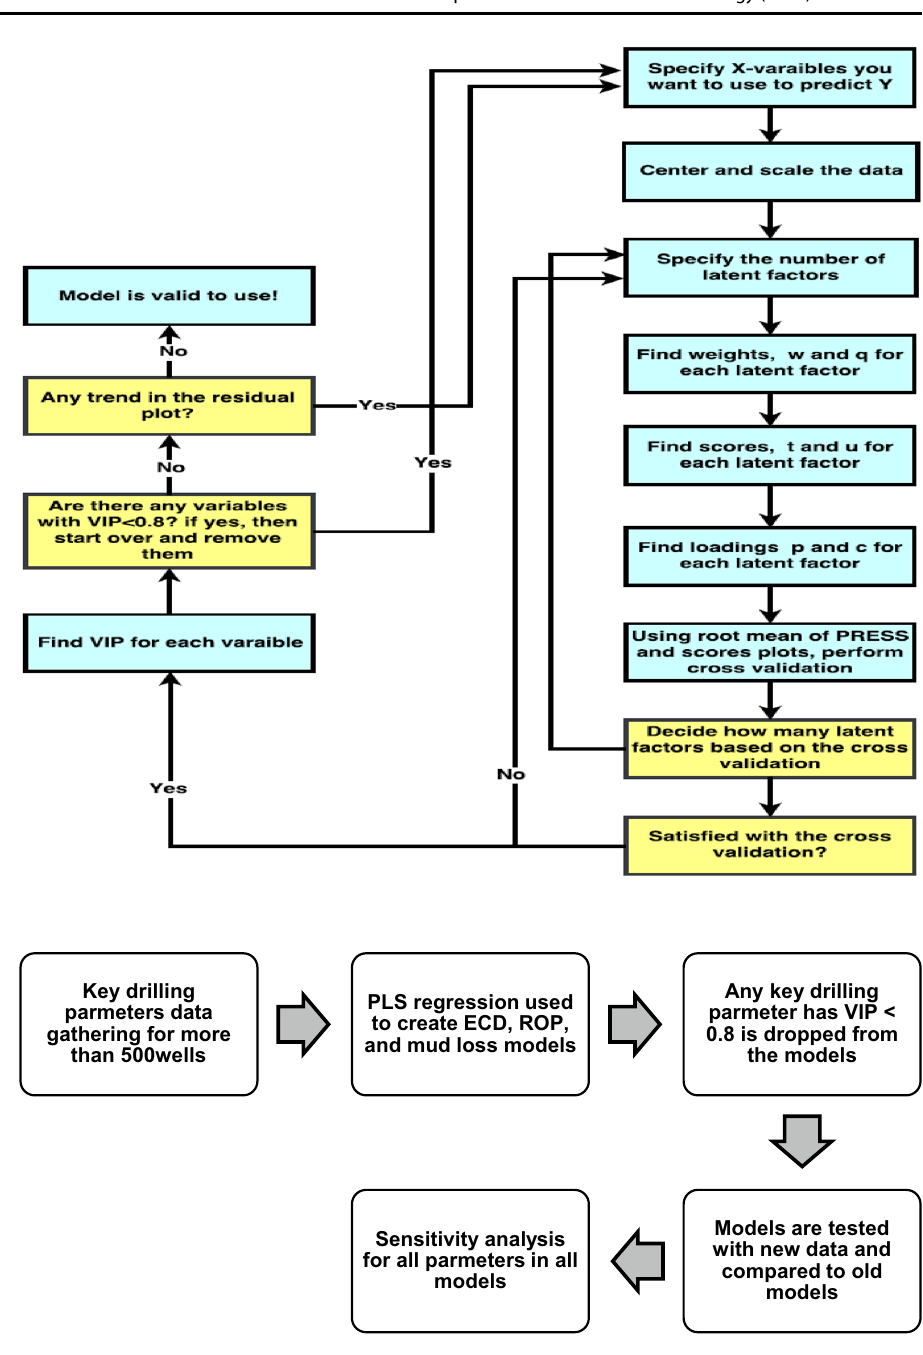
Fig. 4 PLS algorithm summary